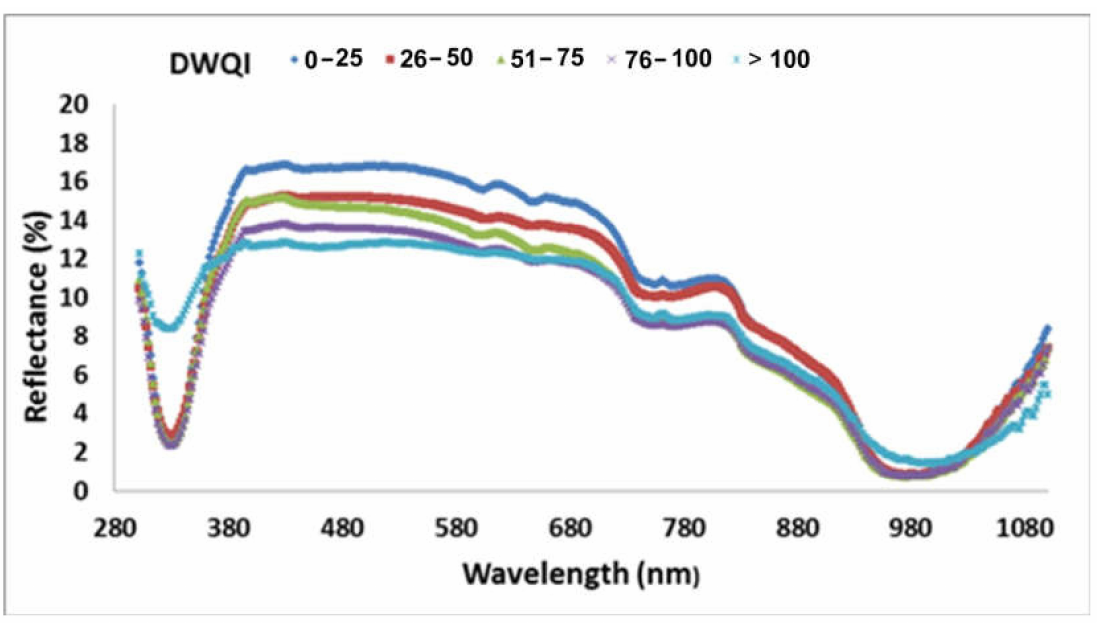
Figure 12. Spectra reflectance of the various levels of drinking groundwater quality index across the three wadies samples.